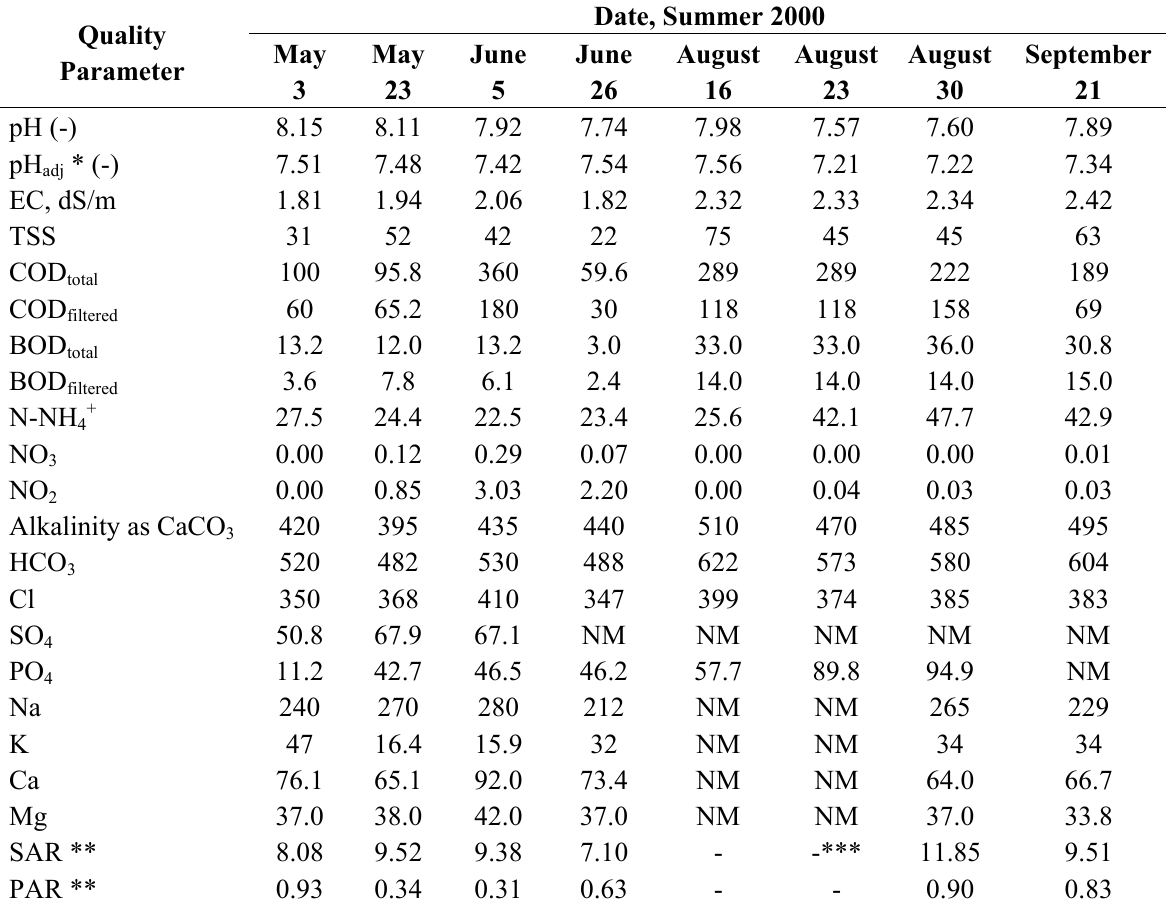
Table 4. Quality of the effluent treated in the integrative membrane system (mg/L), Chafets-Chaim, 2000